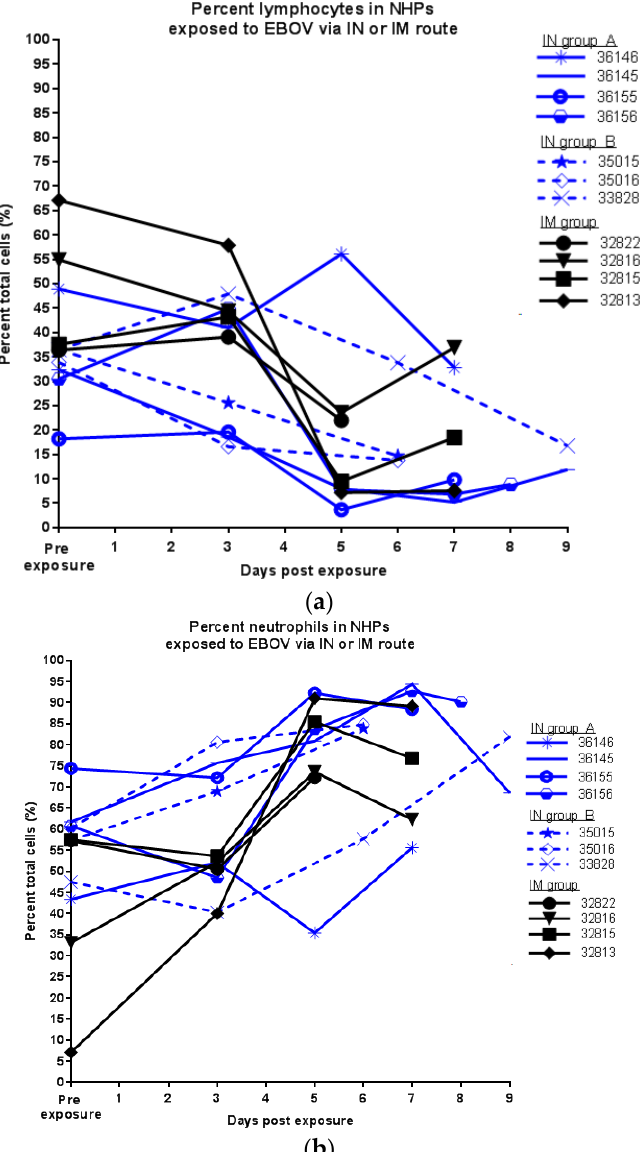
Figure 5. Lymphocytes and neutrophils in NHPs exposed to EBOV via IN or IM routes; ( a ) percentage of lymphocytes; ( b ) percentage of neutrophils.